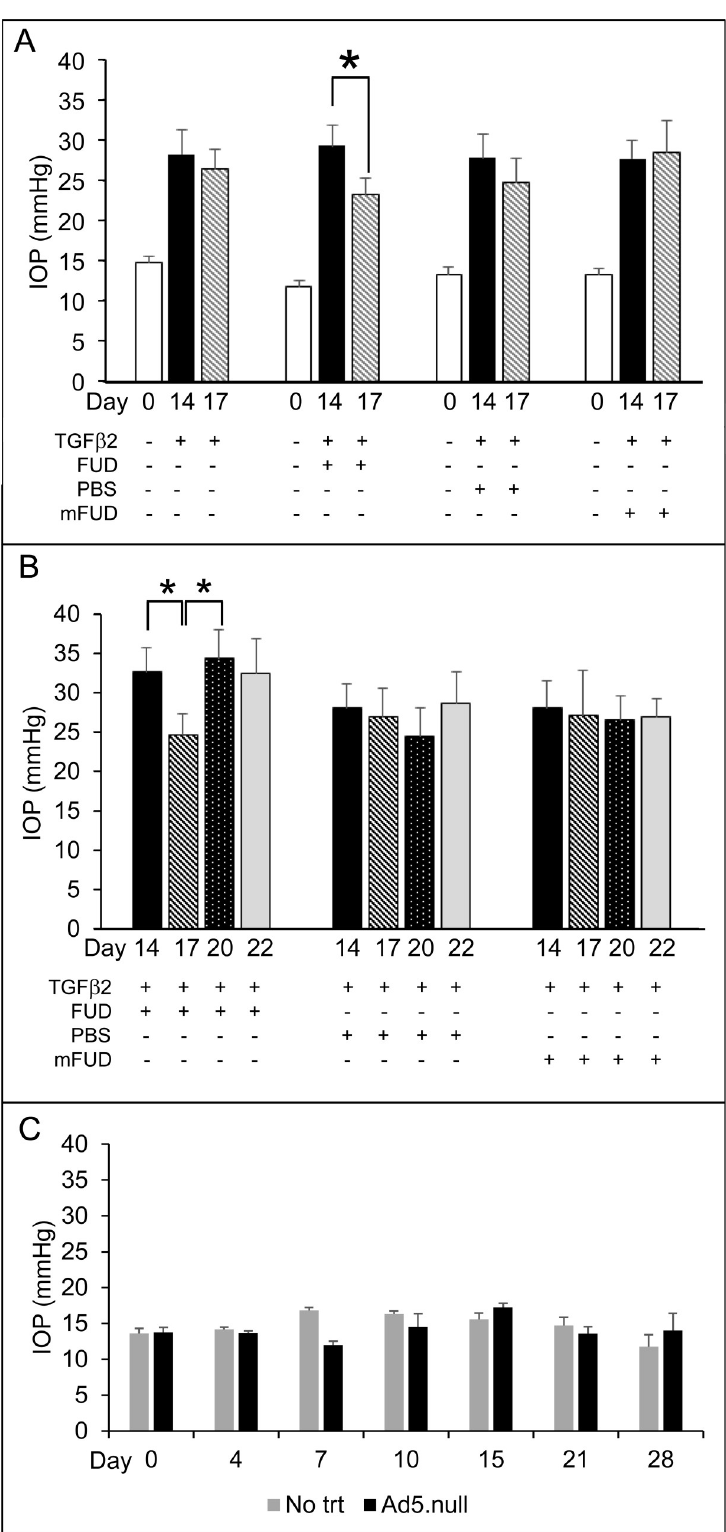
Fig 2. FUD transiently decreased IOP in mice injected with Ad5-TGF β 2 viral vector. (A) Graph shows IOPs measured on Days 0, 14 and 17 in mice injected with TGF β 2 adenovirus. On Day 15, some TGF β 2 transduced